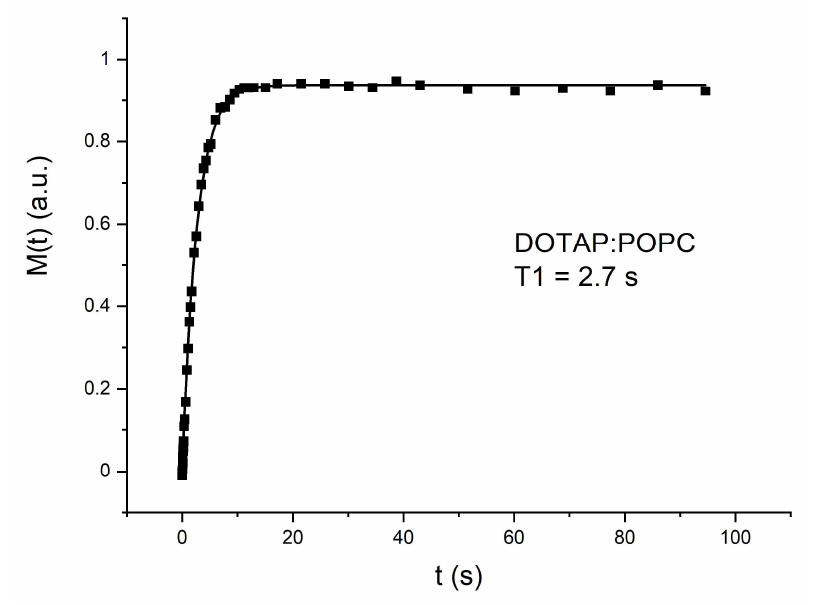
Figure 5. An example recovery of the magnetization as a function of time t for empty liposomes DOTAP:POPC.